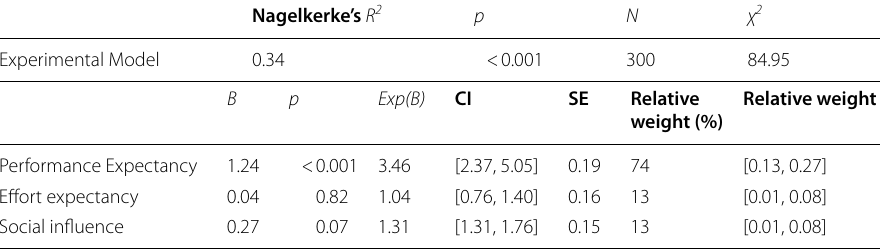
Table 3 Summary of the logistic regression model predicting preference to use VR Nagelkerke’s R 2 p df Experimental